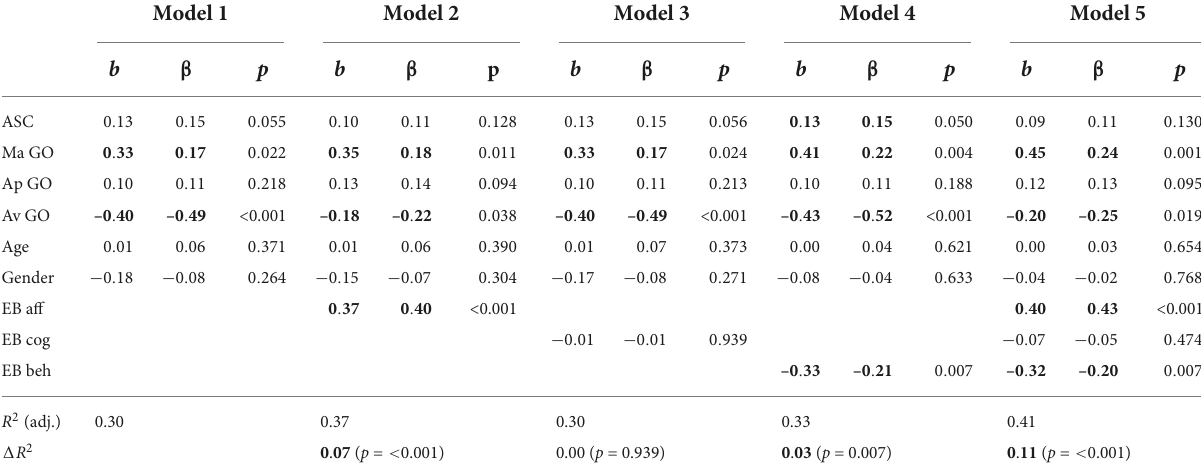
TABLE 2 Stepwise linear regression predicting academic risk taking (seminar group dimension).